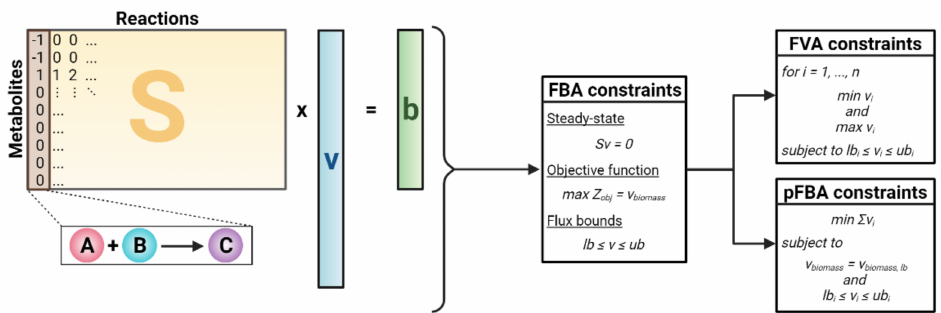
Figure 2. Mathematical framework of three constraint-based modeling (CBM) methods: flux balance analysis (FBA), flux variability analysis (FVA), and parsimonious FBA (pFBA). S = stoichiometric matrix, v = vector of reaction fluxes, b = vector of changes in metabolite concentration, Z obj = objective function, v biomass = biomass reaction flux, lb = lower flux bounds, ub = upper flux